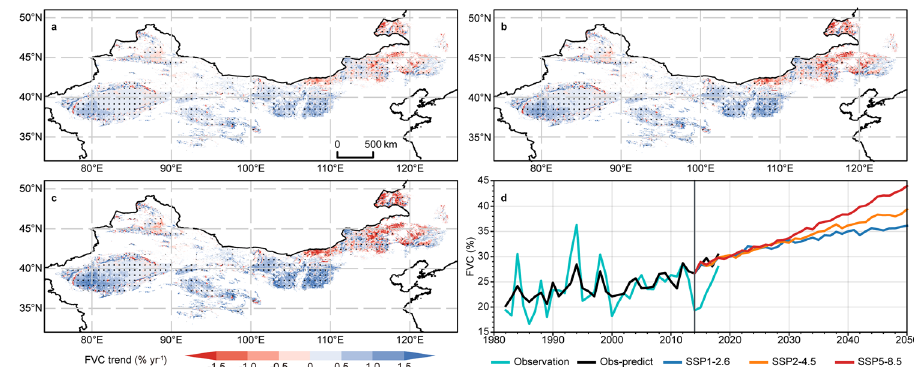
Fig. 4 | Future projections of fractional vegetation cover (FVC) trends. FVC trends estimated by the stepwise multiple linear regression (SMLR) model from 2015 to 2050 under different shared socioeconomic pathway (SSP) and repre- sentative concentration pathway (RCP) scenarios (i.e., SSP1-2.6 a , SSP2-4.5 b , and SSP5-8.5 c ) from the Coupled Model Intercomparison Project Phase 6 (CMIP6) model experiments and their corresponding trend lines d . The stippling in a – c